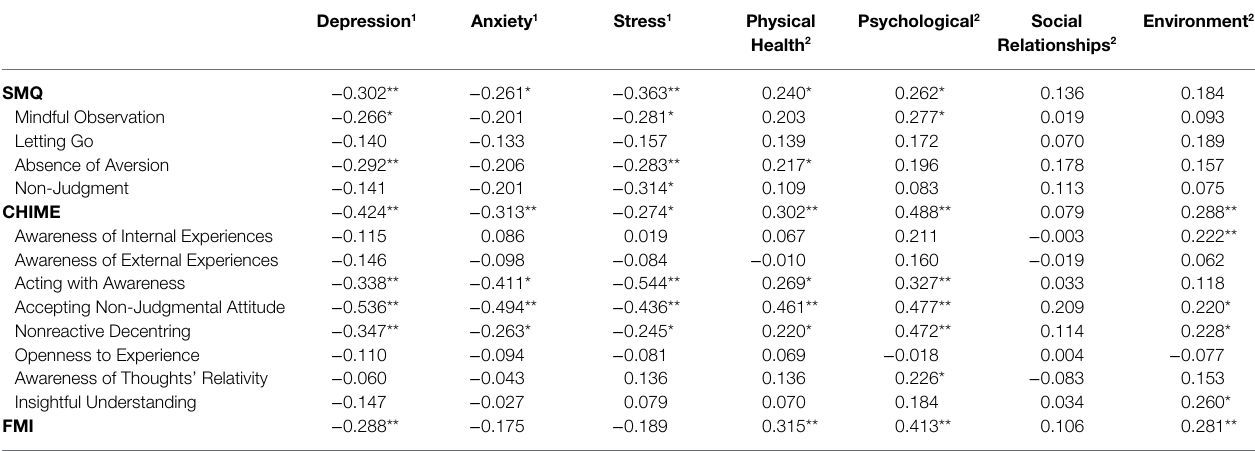
TABLE 3 | Correlations of mindfulness with depression anxiety, stress, and quality of life.